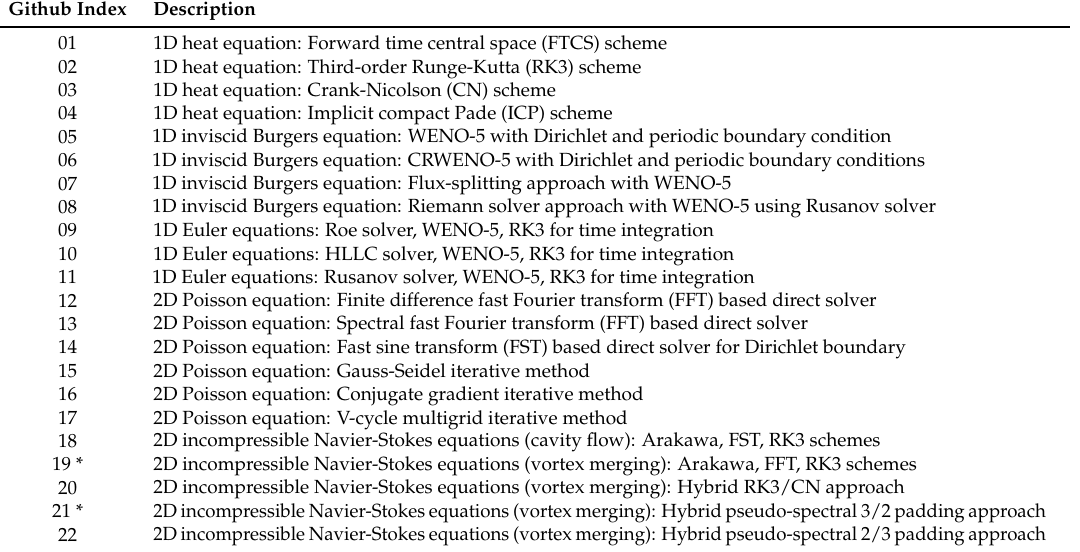
Table 1. Summary of different problems included in the CFD Julia module and the description of topics covered in these selected problems. Source codes are accessible to everyone at https://github.com/sur